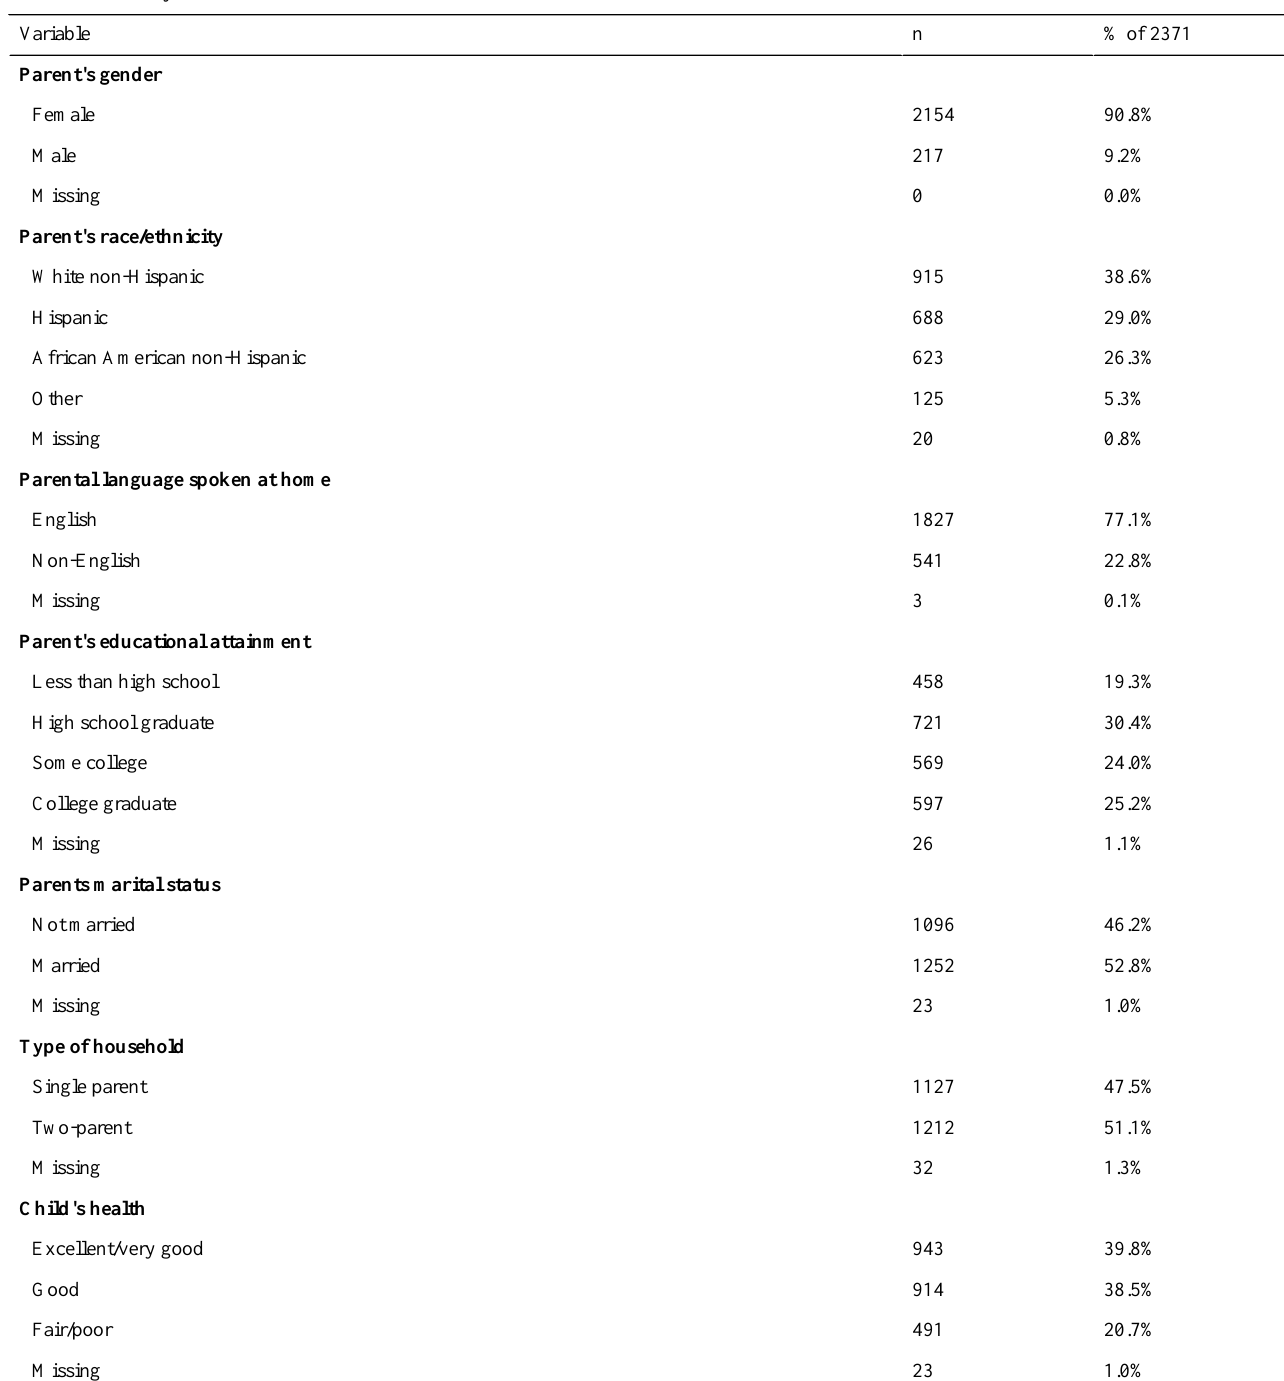
Table 1. Summary